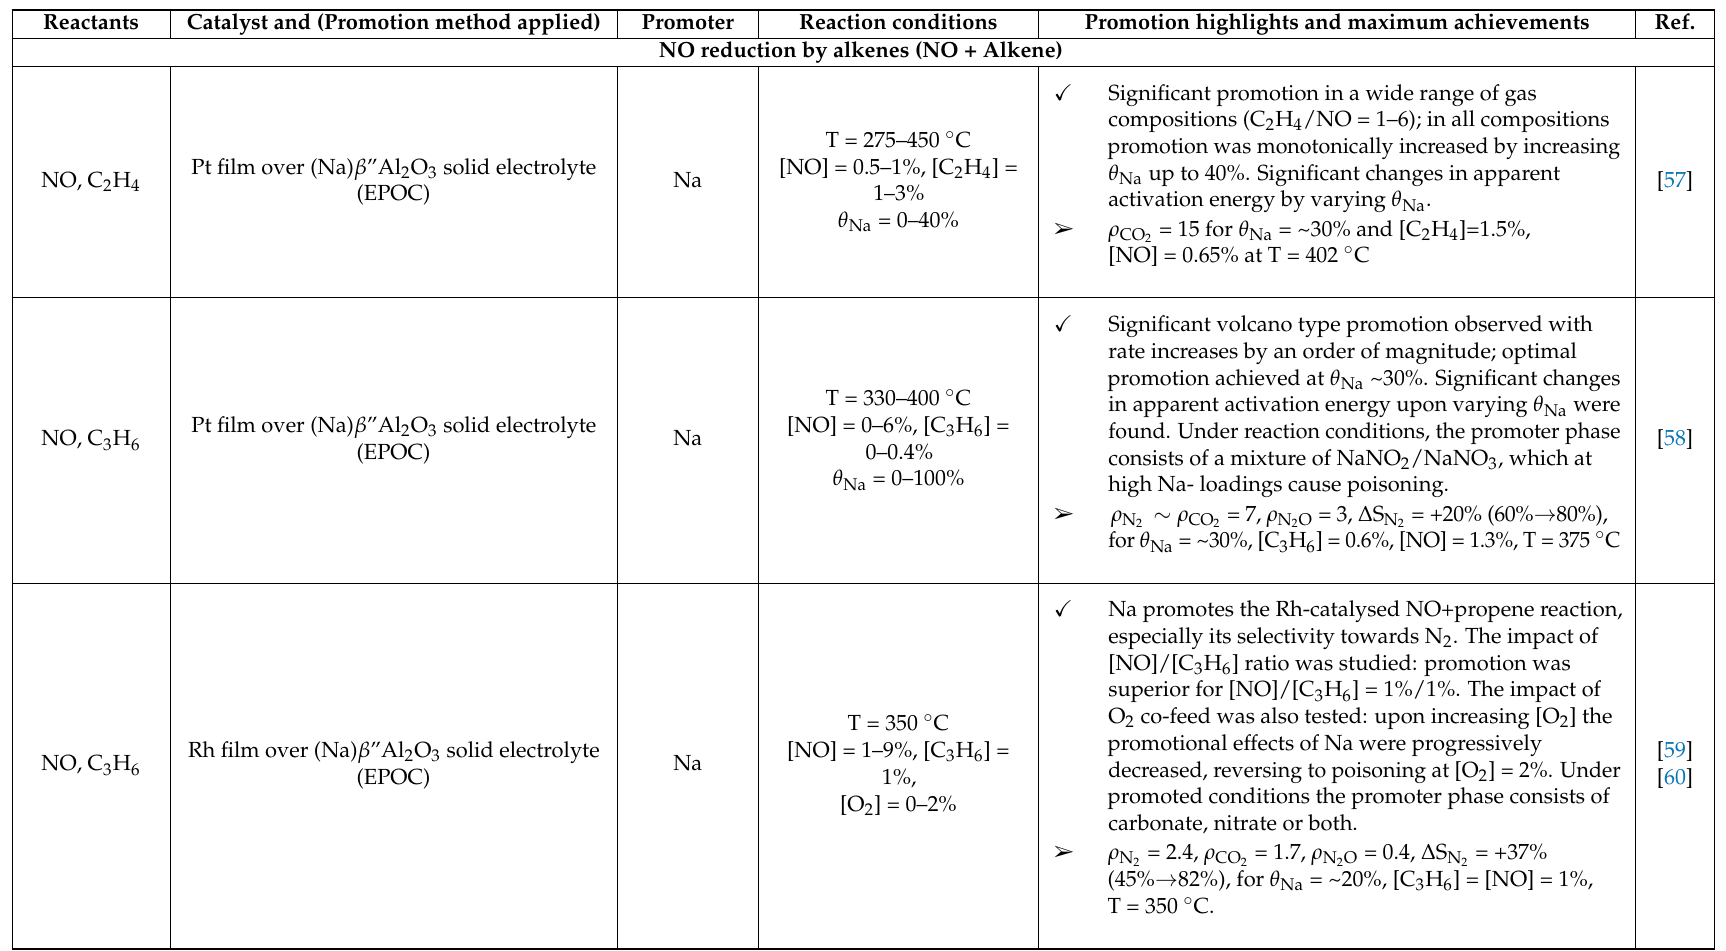
Table 4. Electropositive promotion of PGMs-catalysed NO reduction by hydrocarbons (alkenes or alkanes), H 2 or H 2 +